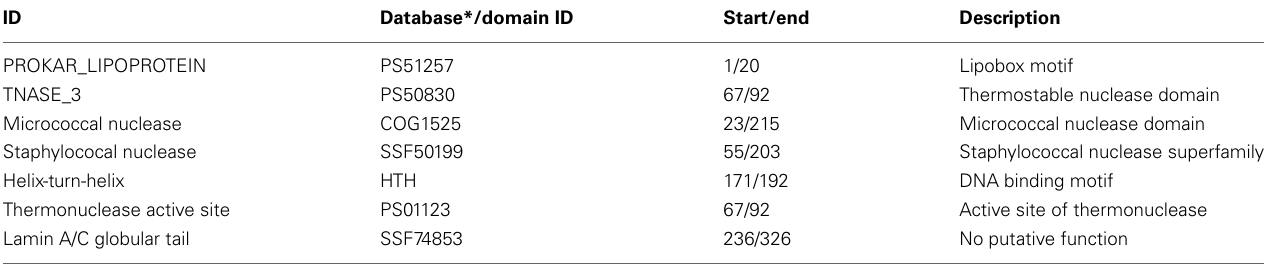
Table 5 | Annotated features/domains of